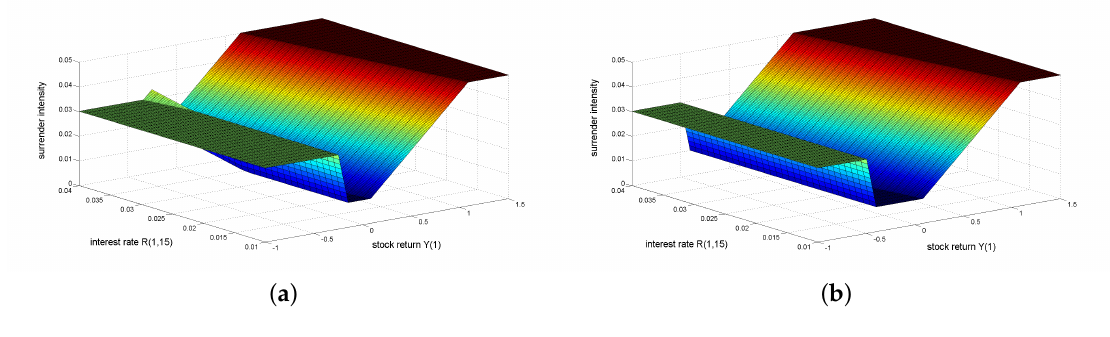
Figure 9. Surrender Intensities of Cases 4 ( a ) and 5 ( b